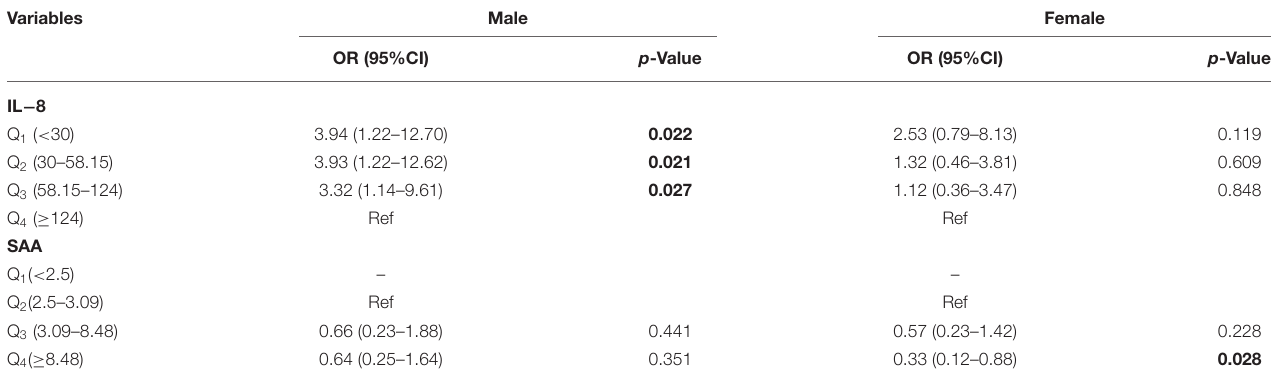
TABLE 4 | Odds ratios (95%CI) of anxiety symptoms associated with IL − 8 and SAA for gender subgroup analysis. Variables